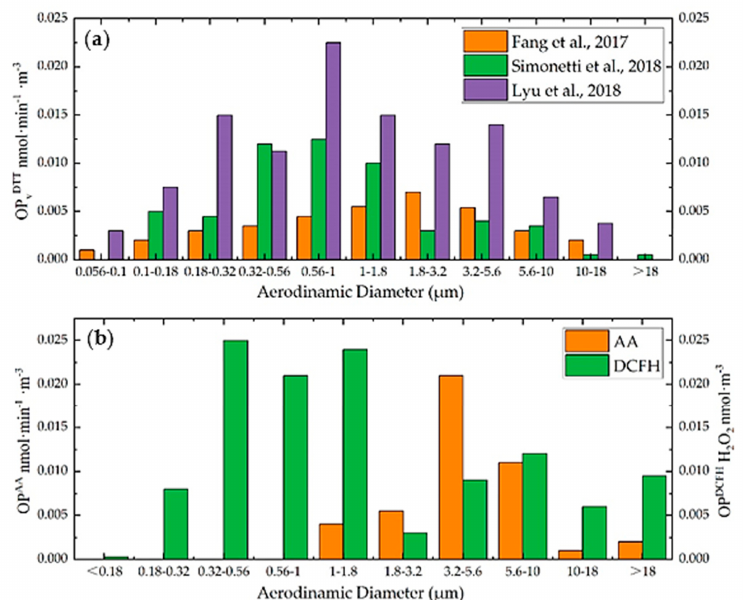
Figure 8. Oxidative potential of water-soluble fraction extracted from different size particles on a per volume unit. ( a ) the highest level of the oxidative potential (OP) was found in the size range from 1 − 2.5 μ m, 0.32–1.8 μ m and 0.56–1 μ m by using DTT assay respectively [24,49,50]; ( b ) OP AA was almost sensitive to particles in the coarse mode (3.2–5.6 μ m) and OP DCFH peaked at 0.32–1.8 μ m